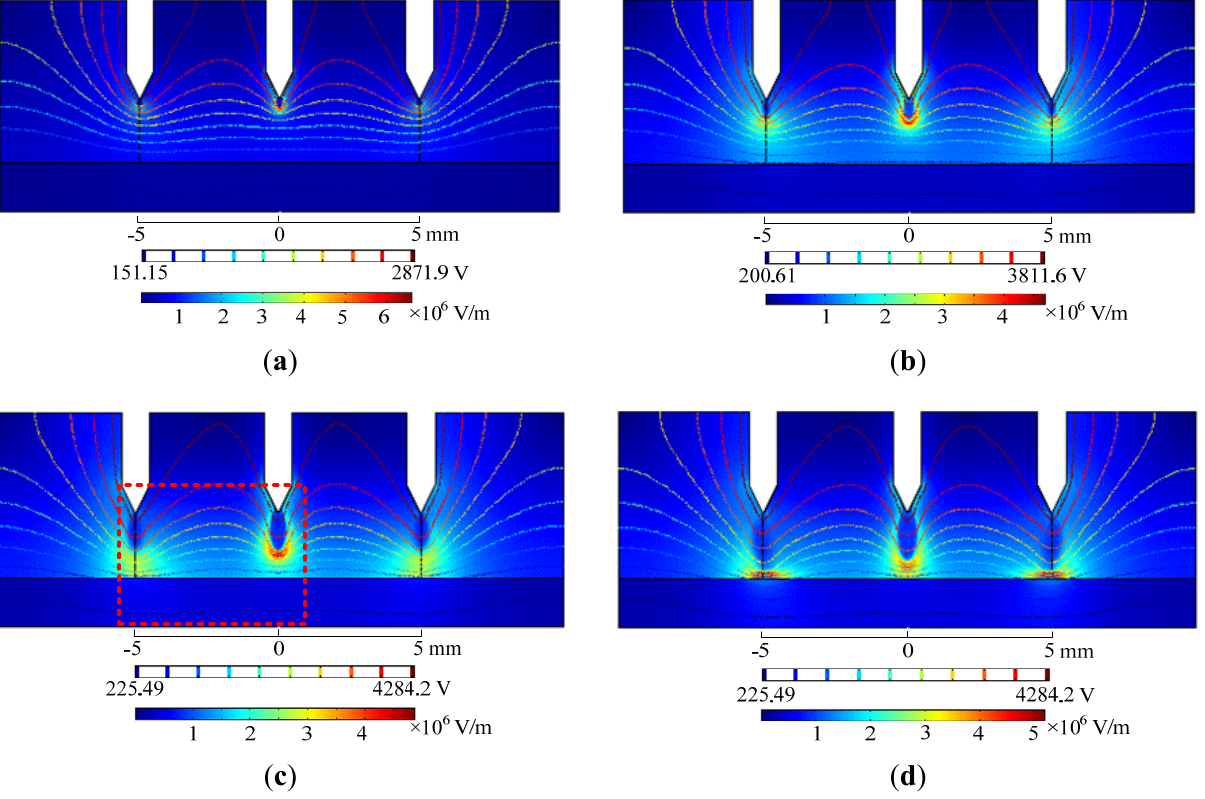
Figure 7. Electric field distribution of a cross section of the TNG: ( a ) 5 ns; ( b ) 7 ns; ( c ) 8.1 ns (the cross section in the dashed frame is the section in Figure 9); ( d ) 8.5 ns.